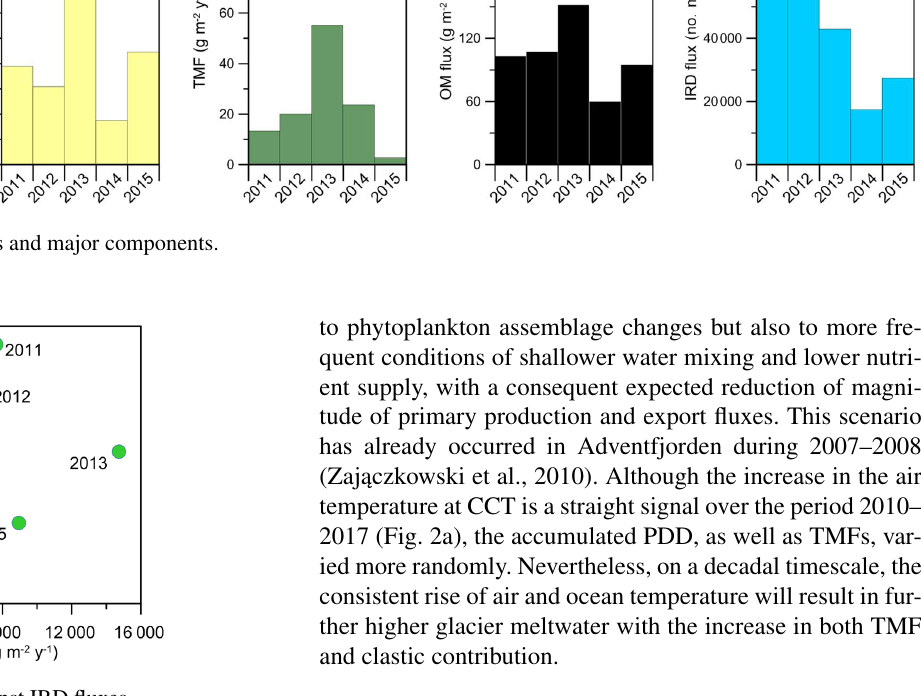
Figure 10. Annual TMF plotted against IRD